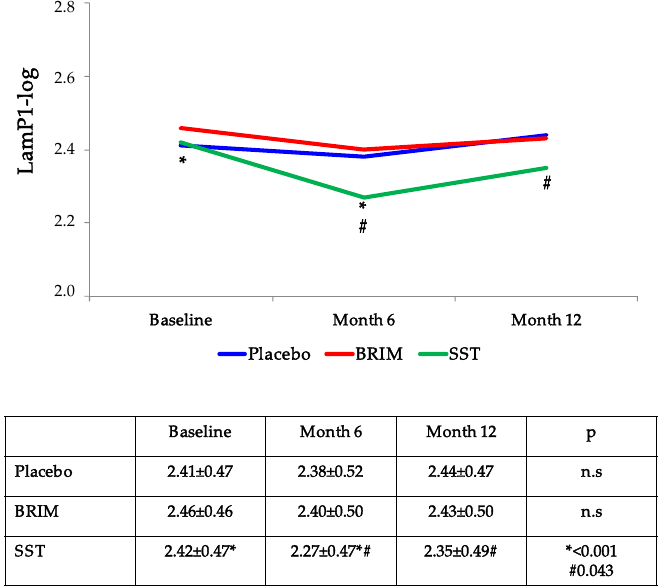
Figure 3. Evolution of Lam-P1 levels (log transformed) in the three therapeutic arms. Lam-P1 levels significantly decrease in type 2 diabetes mellitus patients treated with somatostatin. Lam-P1: laminin P1; BRIM: brimonidine; SST: somatostatin. n.s: non significant. *p<0.001 between Baseline and Month 6. #p=0.043 between Month 6 and Month 12.